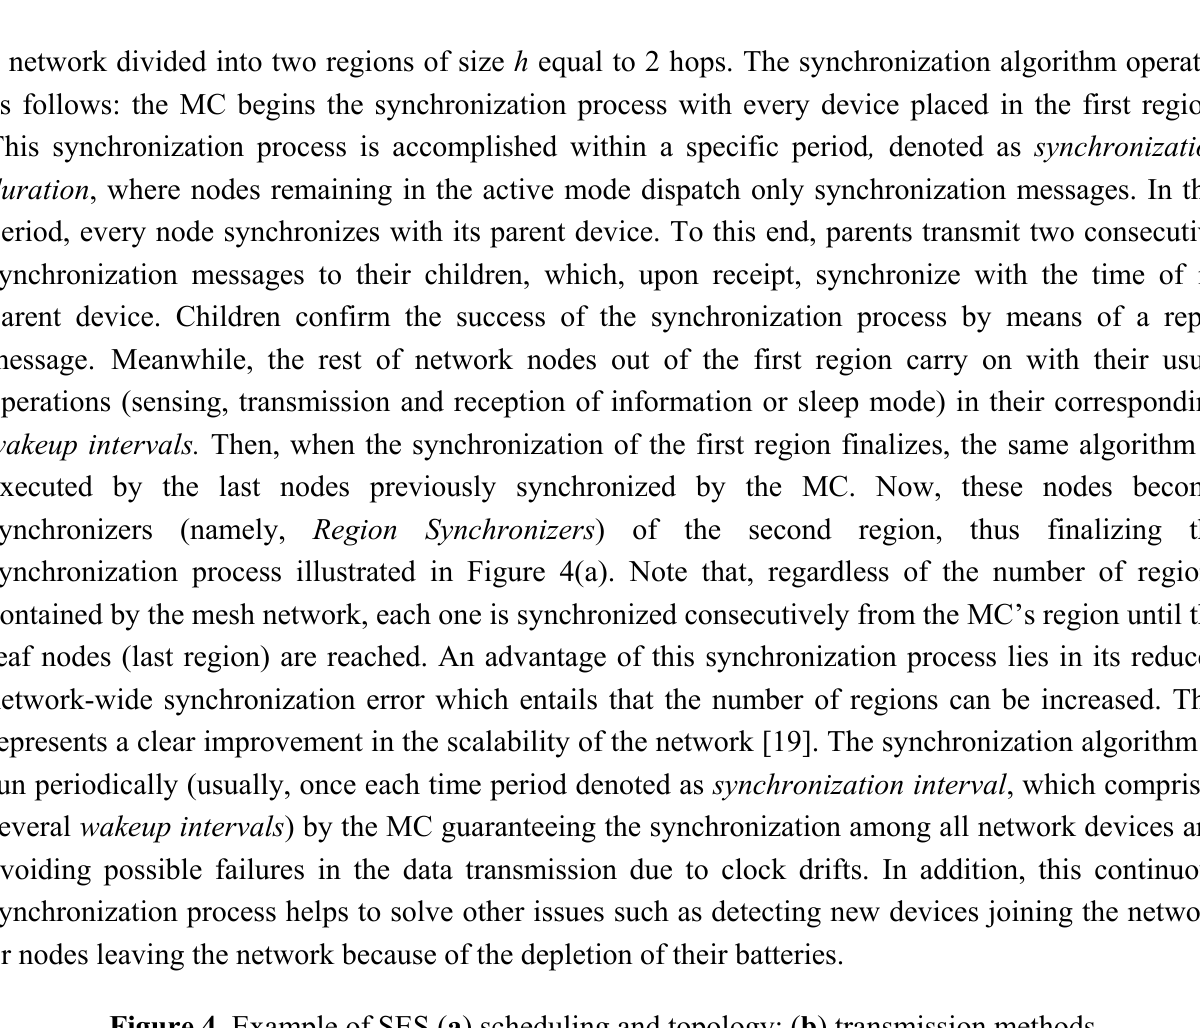
Figure 4. Example of SES ( a ) scheduling and topology; ( b ) transmission